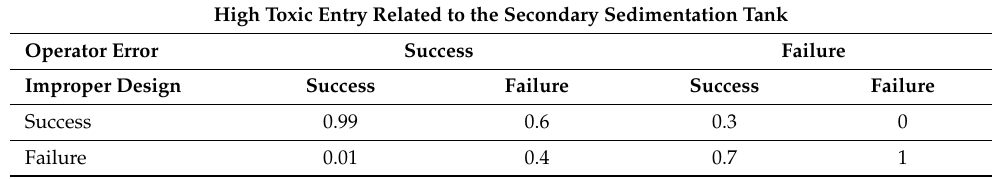
Table 2. The transition CPT for the highly toxic entry related to the secondary sedimentation tank.